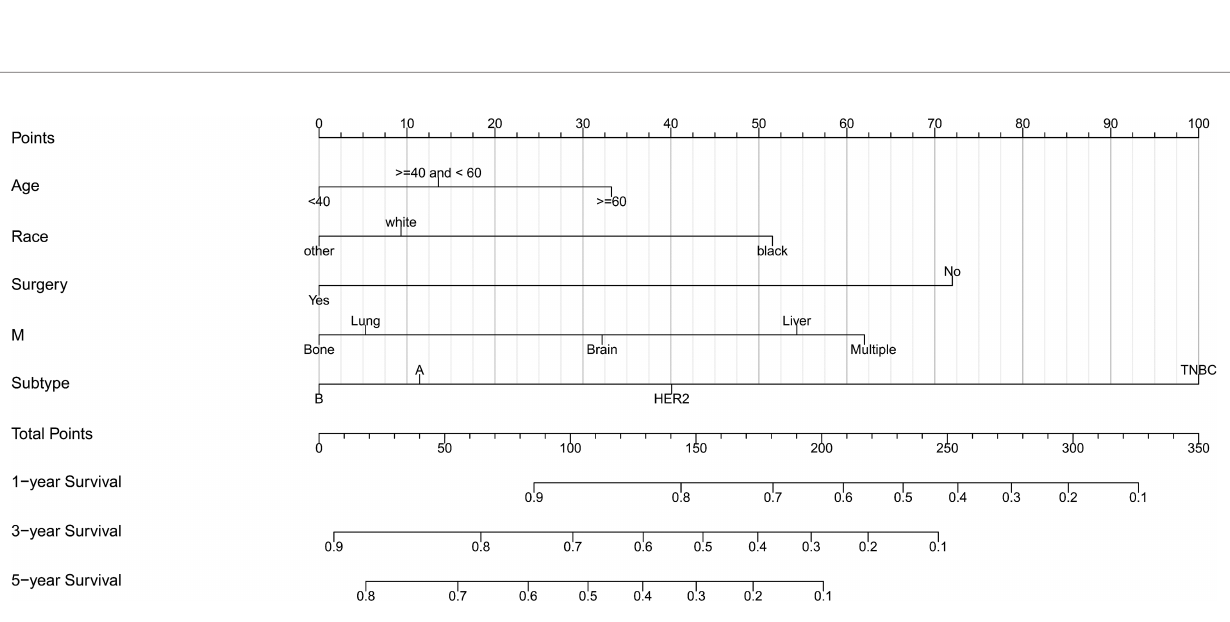
FIGURE 3 | Nomogram for predicting the 1-, 3-, and 5-year CSS in lymph-node-negative women with DM. Other: de fi ned as the Asian/Paci fi c Islander and American Indian/Alaska Native. CSS, cancer-speci fi c survival; A, Luminal A; B, Luminal B; TNBC, triple-negative breast cancer; HER2, Her-2